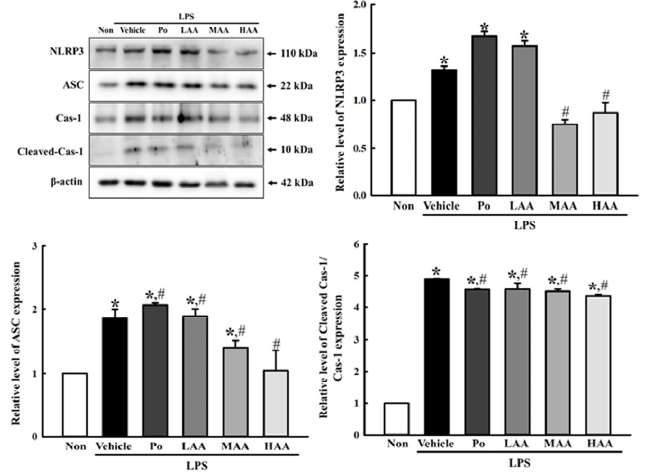
Figure 6. Inflammasome levels in RAW264.7 cells treated with AA. After total cell lysates were prepared from AA+LPS-treated RAW264.7 cells, the expression levels of the key regulators including NLRP3, ASC, Cas-1, Cleaved Cas-1, and β -actin were detected using Western blot analysis. Total cell lysates were prepared from three to five wells per group, and Western blot analyses for each sample were analyzed in duplicate. All values in the results are represented as the means ± standard deviation (SD). * indicates statically significance compared to the non-treated group, while # indicates statistical significance compared to the Vehicle+LPS-treated group. Abbreviations: AA, abietic acid; LPS, lipopolysaccharide; Po, positive control; LAA, low concentration of AA; MAA, medium concentration of AA; HAA, high concentration of AA.